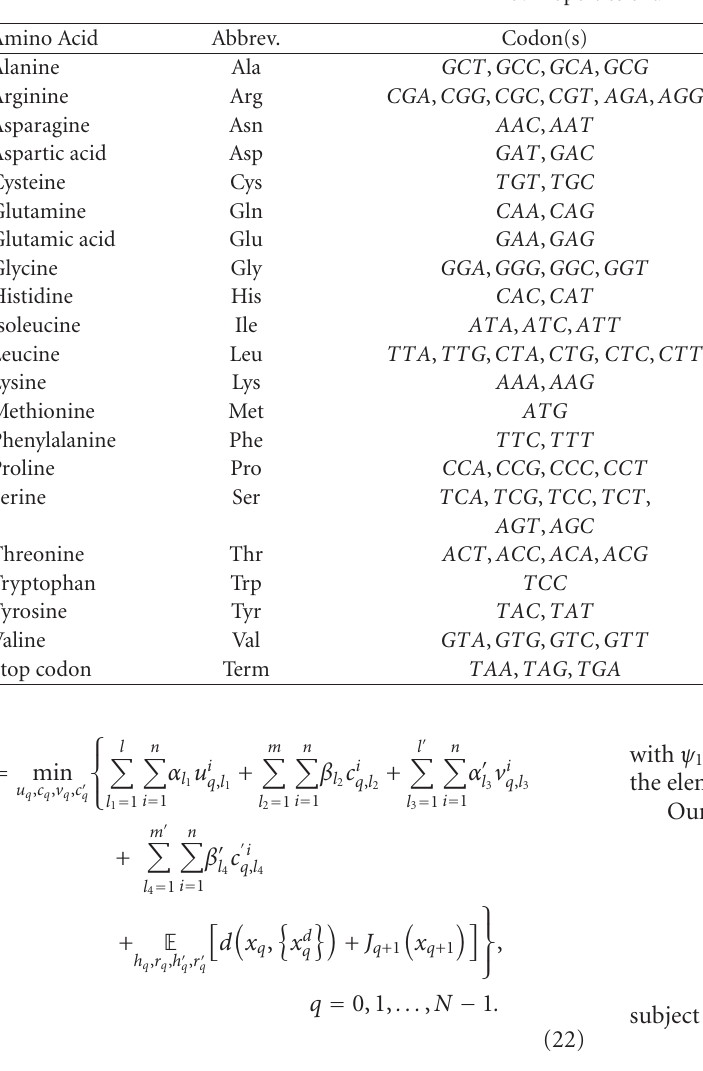
Table 5: Properties of amino